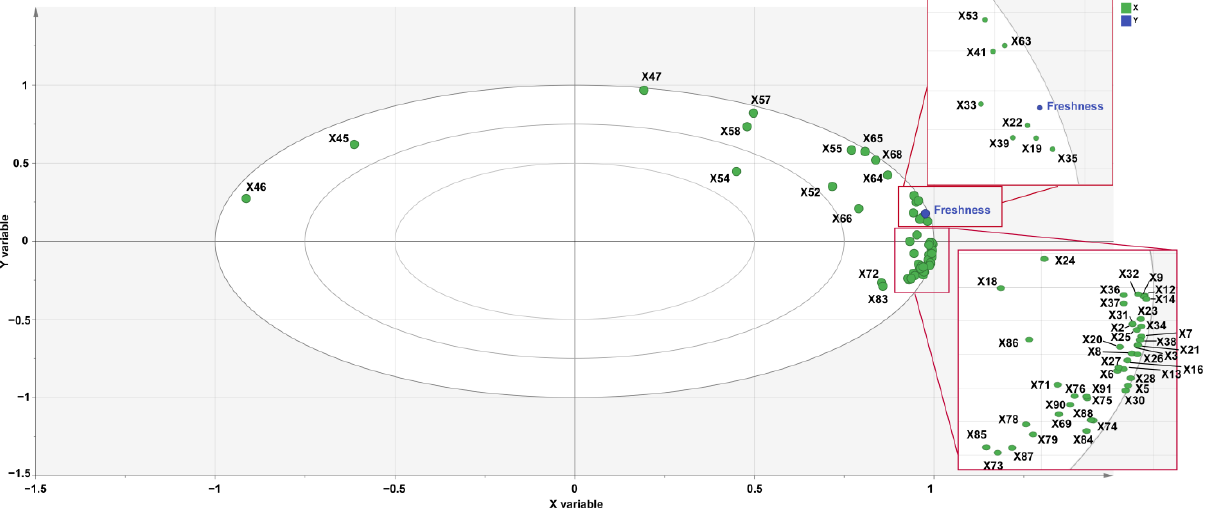
Figure 6. Correlation loading plots analyzed by PLSR. Variant X and Y represent VOCs with OAV > 1 and score of freshness profile evaluation. Green dots represent VOCs with OAV > 1, and blue dots represent freshness. Ellipses represent r 2 = 0.5, 0.75, and 1.0, respectively.